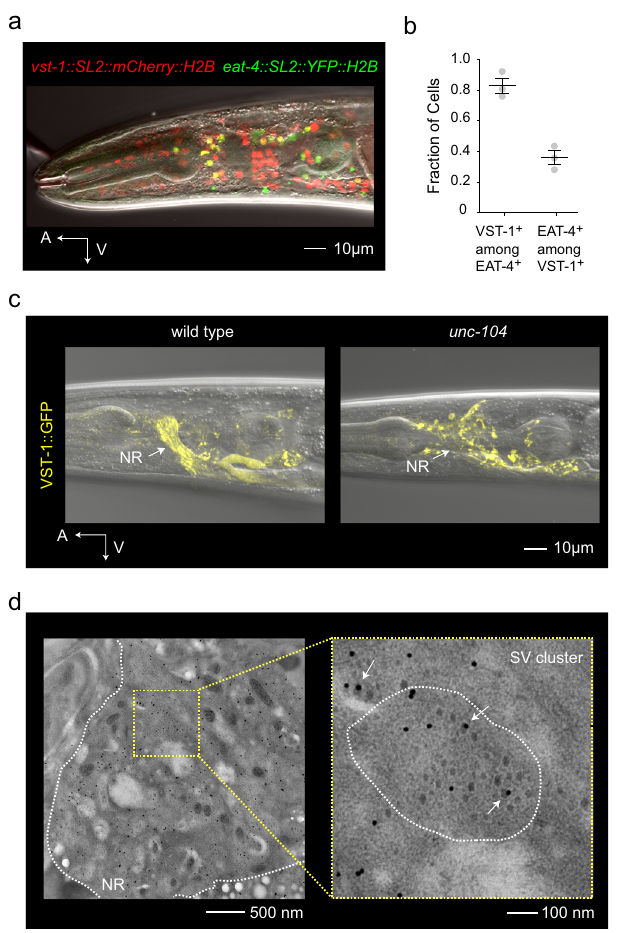
Fig. 2 VST-1 is a synaptic vesicle transporter expressed by a majority of glutamatergic neurons. a Micrograph of an animal expressing fosmid reporters of eat-4/vglut and vst-1 . The eat-4 and vst-1 reporters express nuclear YFP (pseudocolored green) and nuclear mCherry (red), respectively. Anterior (A) and ventral (V) are indicated. b Quanti fi cation of eat-4 and vst- 1 co-expression. The fraction (mean ±SEM) of eat-4 -expressing cells also expressing vst-1 and vice versa was determined from three independent experiments. c Localization of VST-1::GFP to presynaptic domains in the nervous system. The left panel shows a representative micrograph of a wild- type animal, in which VST-1::GFP is highly localized to the nerve ring (NR), marked with an arrow. The right panel shows VST-1::GFP expression in unc- 104/kinesin mutants, which is required for proper transport of synaptic vesicle components into axons. The micrographs are representative of images taken from four animals for each genotype. d Immunoelectron micrograph of a strain expressing VST-1::GFP and stained with anti-GFP antibodies detected with 15 nm gold particles. The left panel shows a fi eld of view at a magni fi cation of ×25,000. The boundary of the nerve ring (NR) is marked by a dashed white line. The right panel shows a magni fi ed view of the synaptic vesicle (SV)-rich region indicated by dashed yellow lines. The dashed white line in the right panel indicates the perimeter of a single neurite cut in cross-section. Immunogold particles (15 nm) show the expression of VST-1::GFP. Arrows indicate immunogold associated with synaptic vesicles. The micrograph is representative of at least 25 micrographs taken of different regions of the nerve on vesicular pH. To distinguish these possibilities, we used BAG neurons. Measurements of total and surface-accessible pHluorin (Fig. 3g) allow computation of vesicular pH 42 . We observed that wild-type synaptic vesicles had a mean pH of 6.2